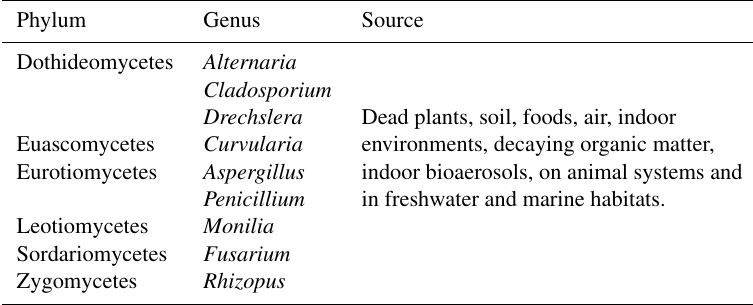
Table 4. Fungal identification on MEA media for the whole sampling period. Phylum Genus Source Dothideomycetes Alternaria Cladosporium Drechslera Dead plants, soil, foods, air, indoor Euascomycetes Curvularia environments, decaying organic matter, Eurotiomycetes Aspergillus indoor bioaerosols, on animal systems and Penicillium in freshwater and marine habitats. Leotiomycetes Monilia Sordariomycetes Fusarium Zygomycetes